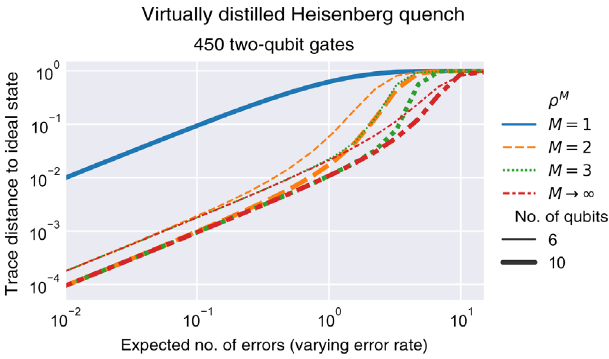
FIG. 8. The error in the unmitigated noisy states ( M ¼ 1 ), the states accessed by virtual distillation ( M ¼ 2 , 3), and the dominant eigenvectors of the density matrices ( M → ∞ ), for states generated by the Trotterized time evolution of a Heisenberg model. We plot the trace distance to the state obtained from noiseless evolution as a function of the expected number of single-qubit depolarizing errors. The expected number of errors is varied by changing the error rate per gate, fixing the number of two-qubit gates to be 450. We show these data for six- and ten- qubit systems (differentiated by the size of the markers). As we increase the system size from six qubits to ten, we observe that the error (quantified by the trace distance to the ideal state) decreases for the error-mitigated states ( M > 1 ).